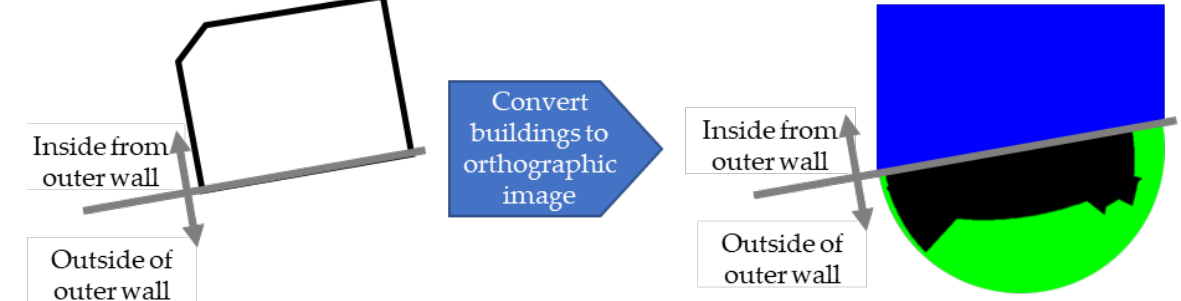
Figure 6. Orthographic image converted for exterior walls.